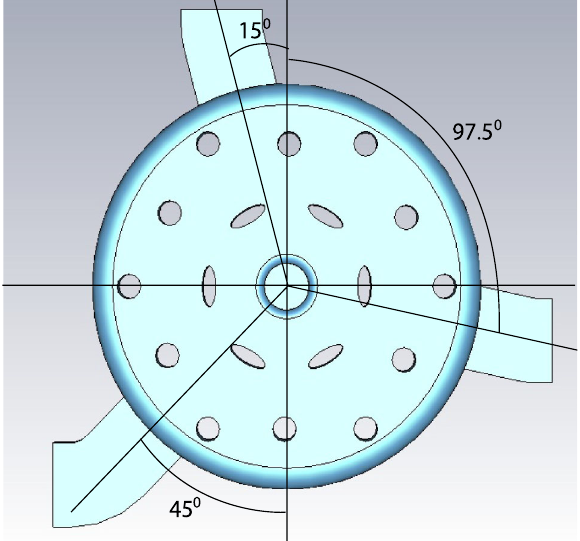
FIG. 9 (color online). The PBG resonator with six elliptical rods and three WR-229 attached for coupling out HOMs.